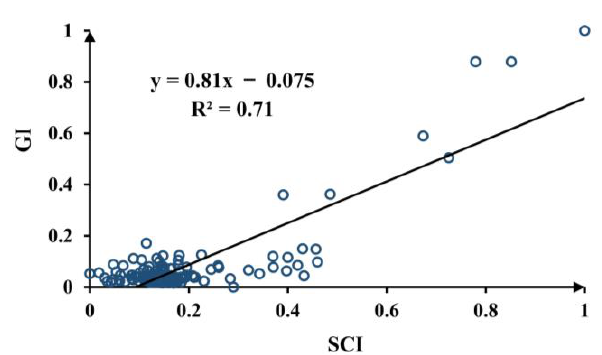
Figure 6. The normalized OOB errors of different NTL features.